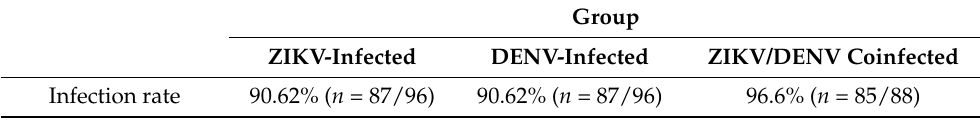
Table 1. Infection rate for DENV or ZIKV single infection and DENV/ZIKV coinfection.